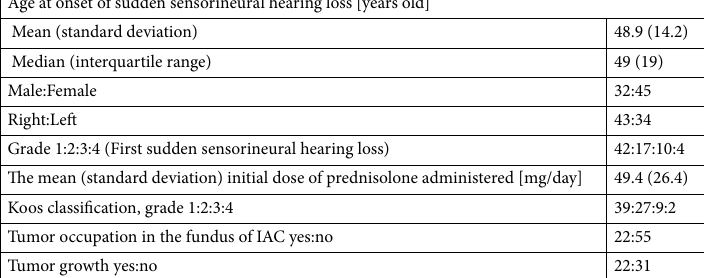
Table 1. Clinical data of the